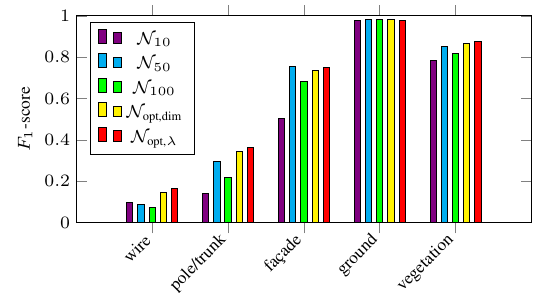
Figure 4: F 1 -scores for RF-based classification.